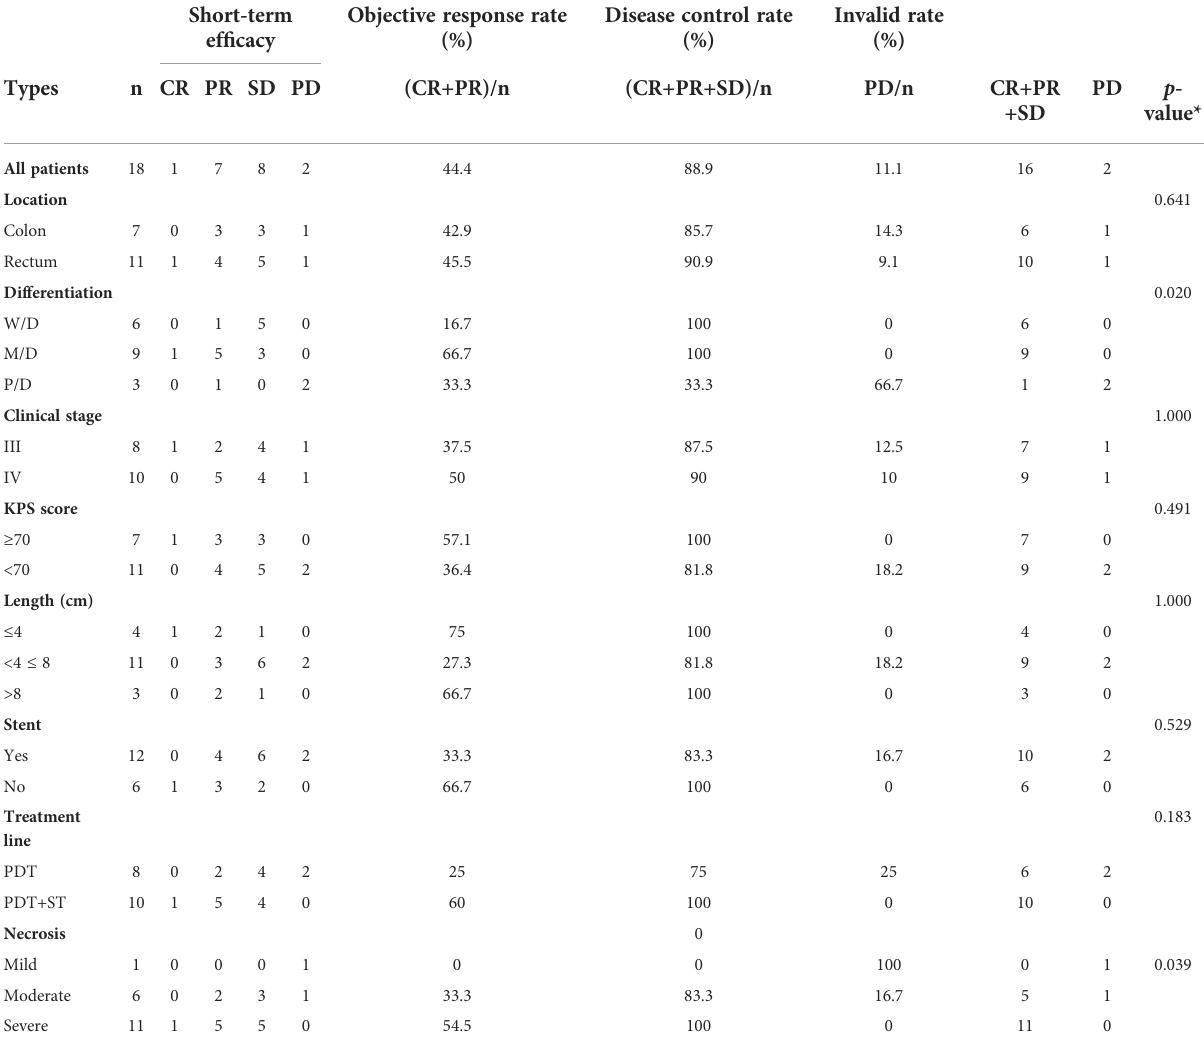
TABLE 3 Short-term ef fi cacy and the ef fi cacy comparison of different